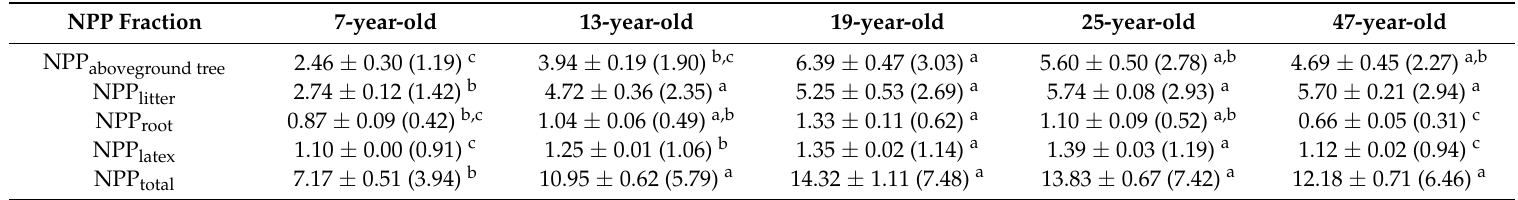
Table 3. Net primary productivity (NPP) (t ha − 1 year − 1 ) and carbon stock (in brackets Mg C ha − 1 year − 1 ) in different compartments of the 7-, 13-, 19-, 25-